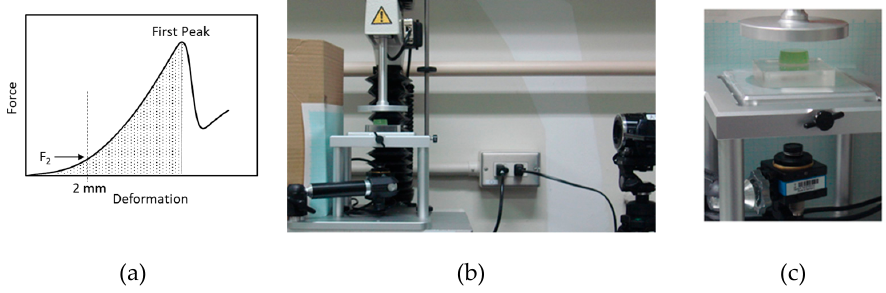
Figure 1. Typical force–deformation curve of a gellan gel ( a ) and setting for compression test of soft foods between an artificial tongue and plate ( b , c ). ( b ) Whole setup and ( c ) enlarged view around the sample. A food gel ( φ 20 × 10 mm) on a transparent artificial tongue (50 × 50 × 10 mm) was placed on a glass plate of a TA.XT plus Texture Analyser. Upper plate connected to a load cell was moved downward at a constant speed, and sample deformation was observed from the bottom and/or from the right side by video cameras during the compression test.